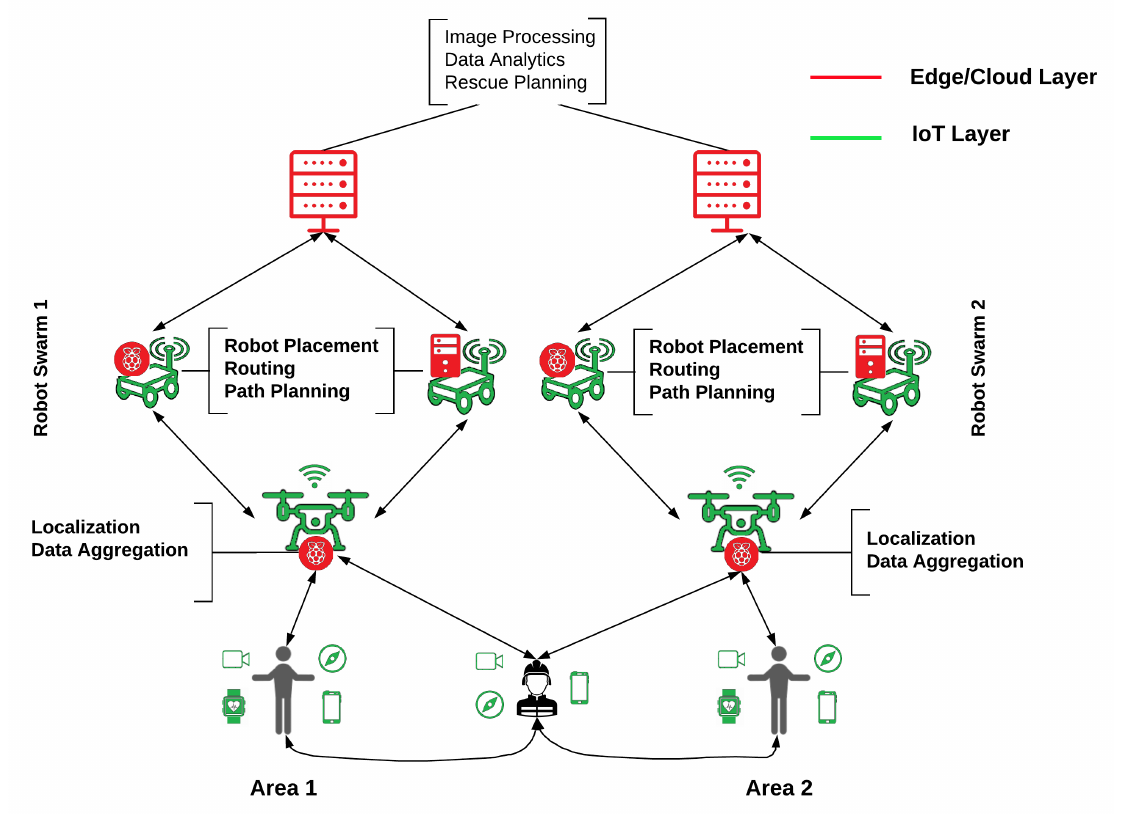
Figure 3. Rapid resource development for physical